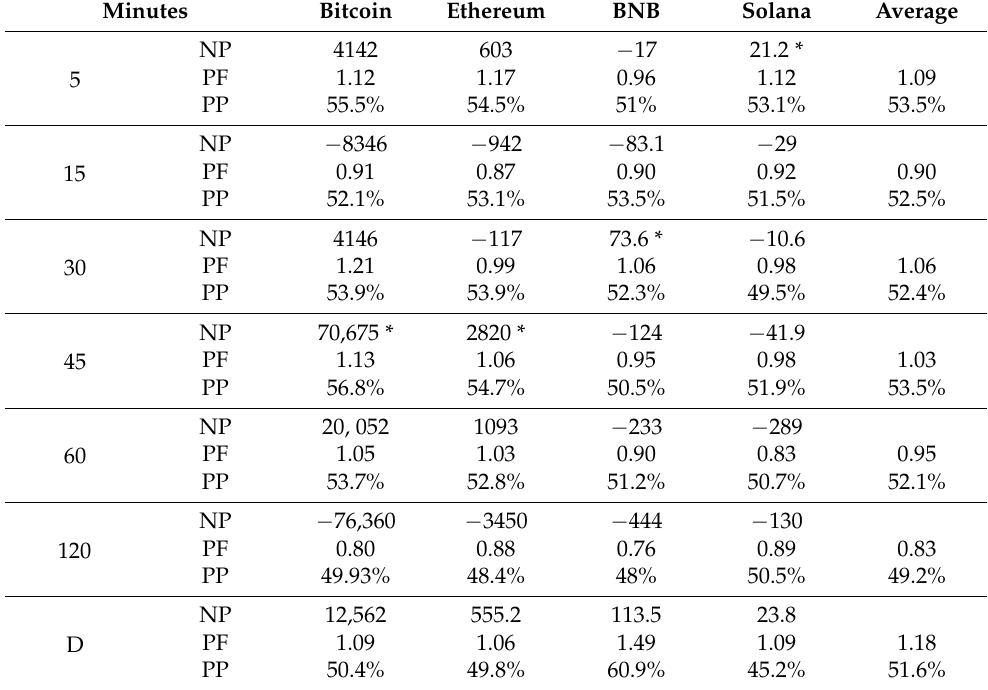
Table 2. Results of CMF trading